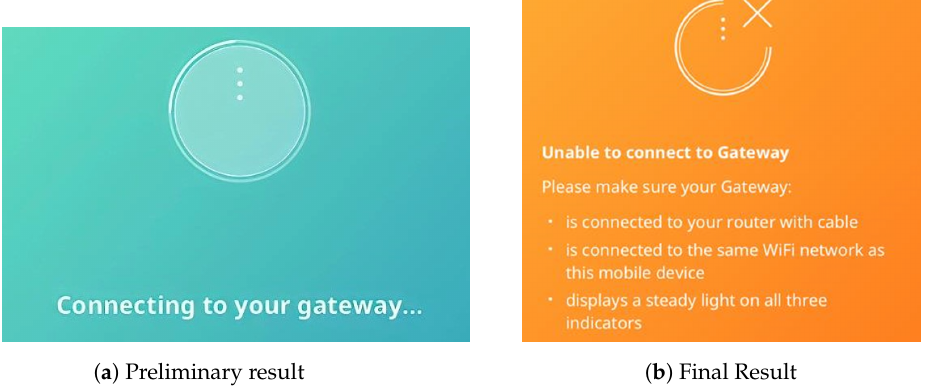
Figure 8. Preliminary and final results of network congestion on the IKEA Home Smart